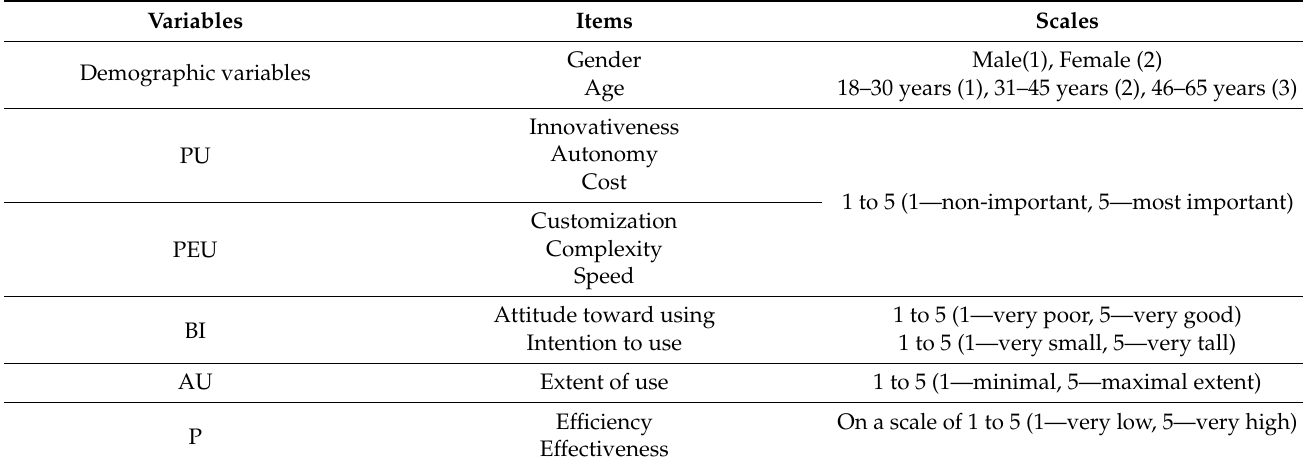
Table 1. Questionnaire design (constructs and items).